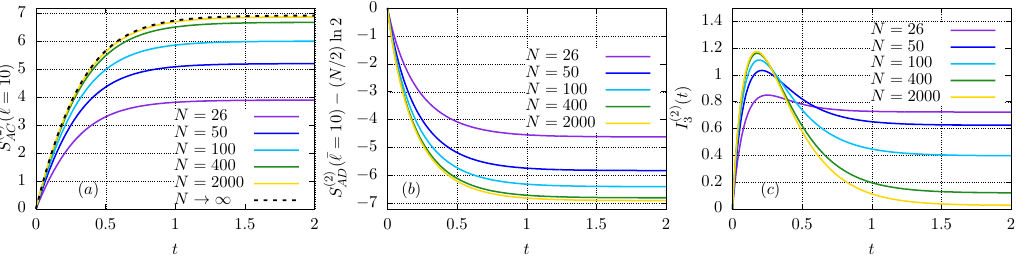
Figure 12 . For the free case ( q = 2), we show the time behavior of the entanglement entropies S (2) (a), S (2) (b) and tripartite information I (2) (c) for several system sizes N and (cid:12)xed subsystem 3 AC AD size (cid:22) ‘ = 10. In (a), we also indicate the limit (A.13). The tripartite information is always positive, which means that the non-interacting system does not scramble quantum information.